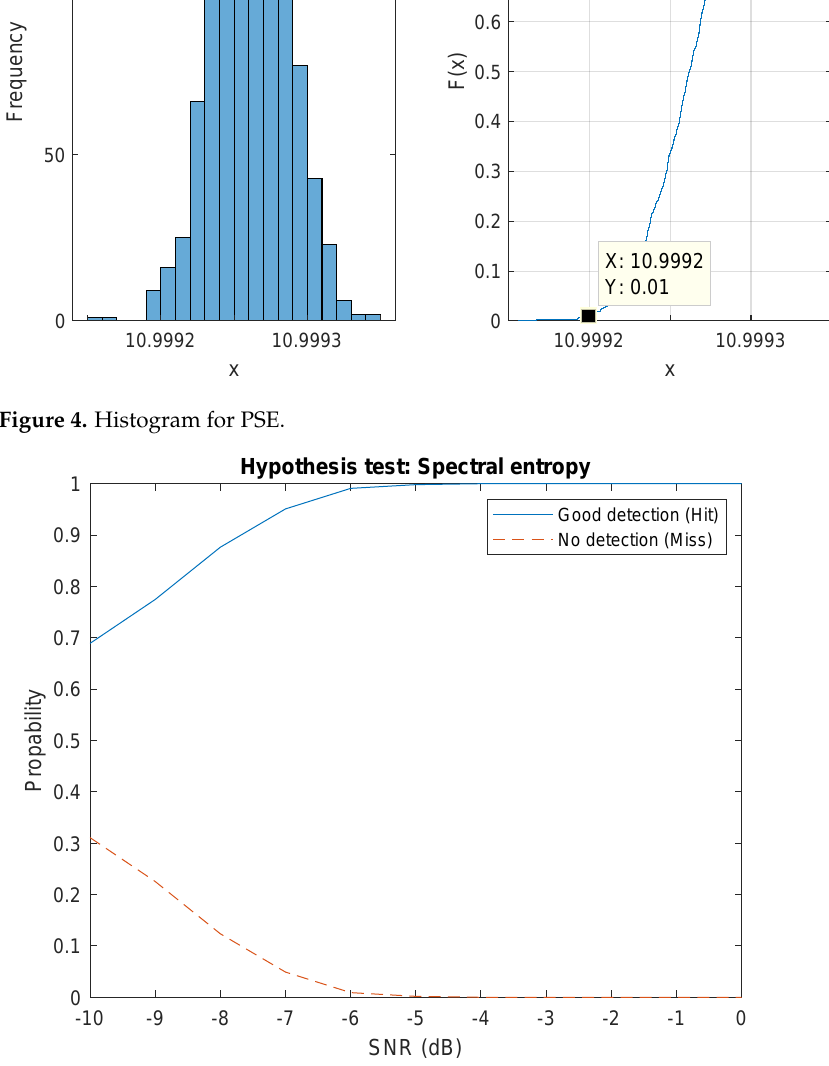
Figure 5. Results for